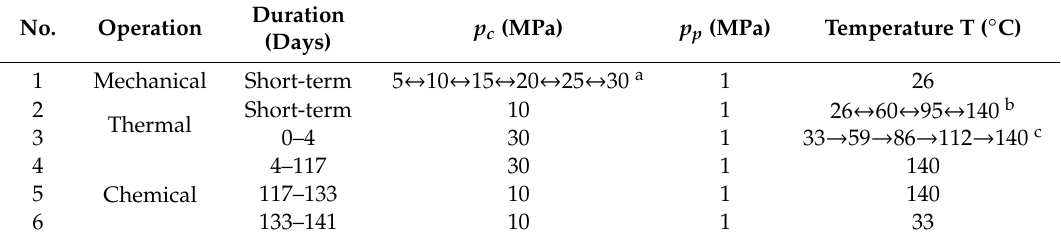
Table 1. Experimental conditions (pressures and temperatures) and the duration of each